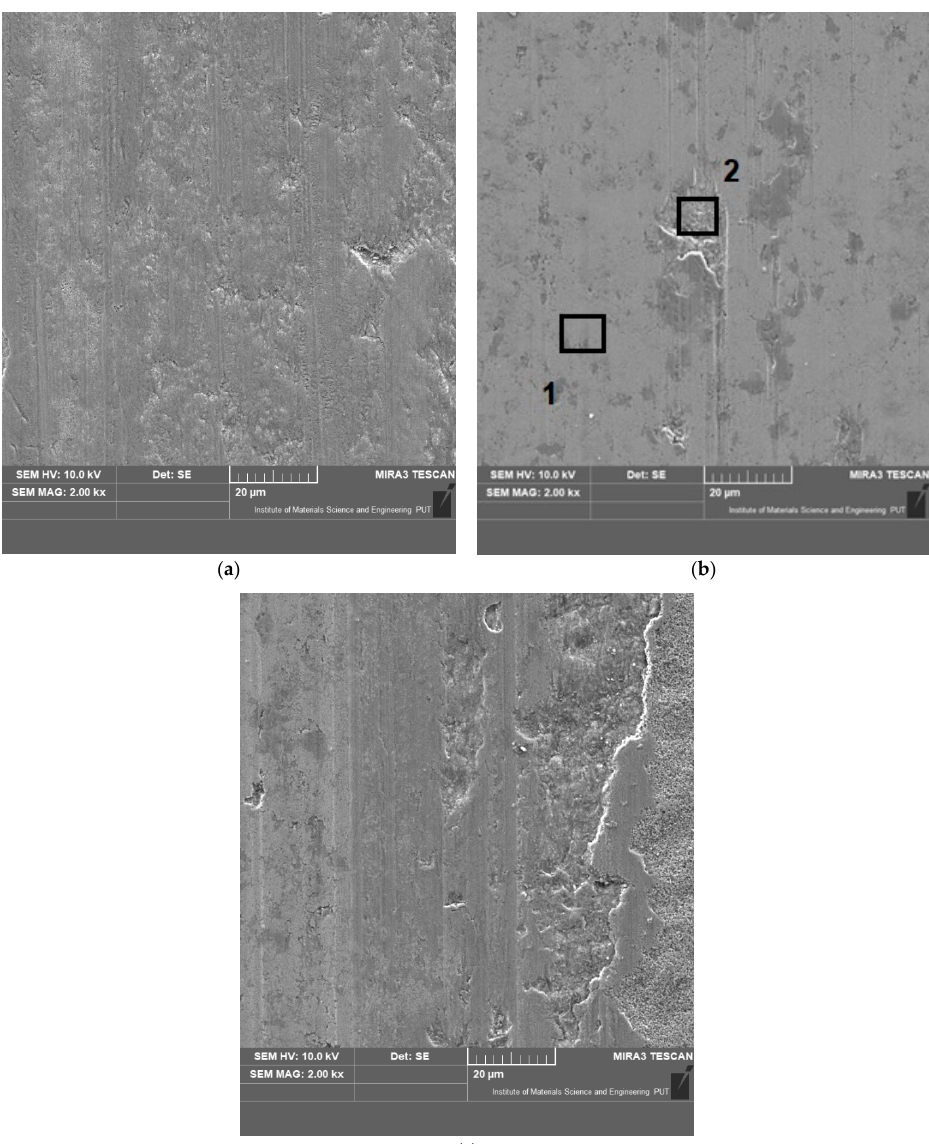
Figure 9. Pictures of the wear trace surface for the gas nitrided coating at an open circuit potential, E OCP , under specific loads: ( a ) 9 N, ( b ) 13 N, ( c ) 19 N.